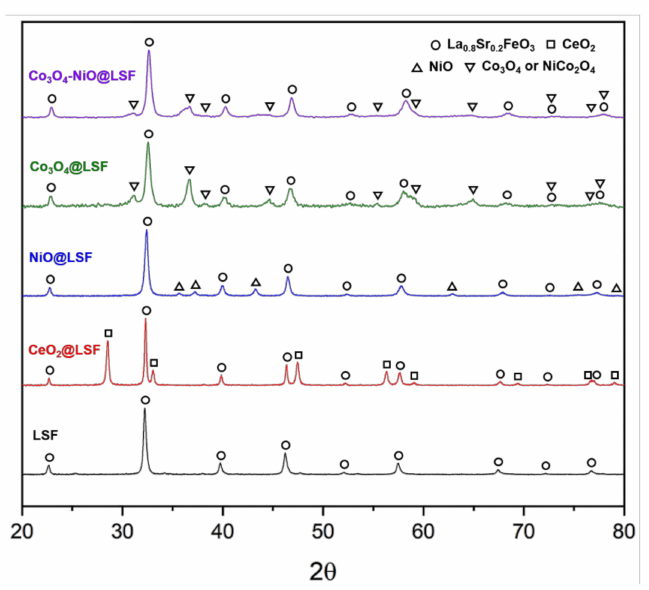
Figure 2. XRD spectra of the oxygen carriers.